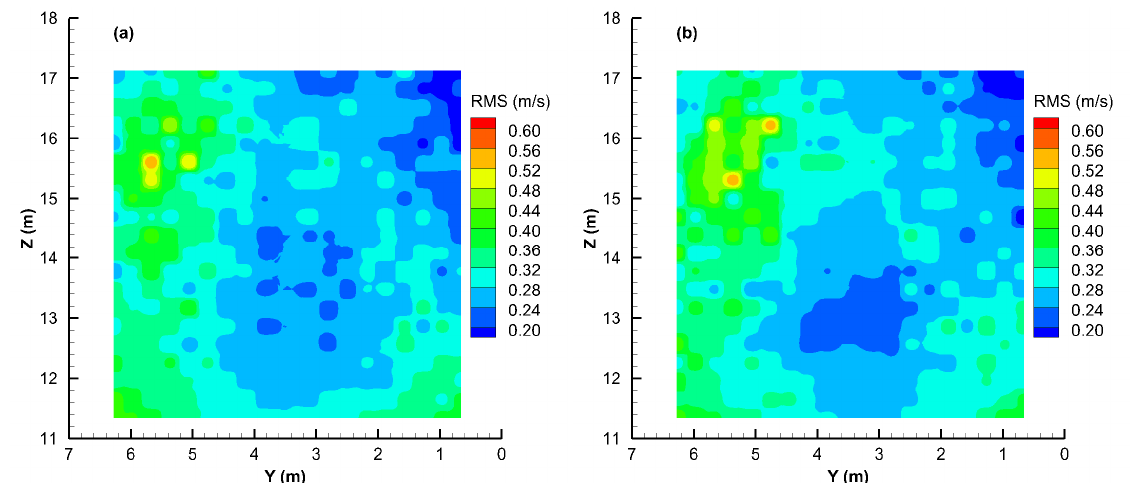
Figure 7. RMS velocity fluctuation contour at unit 14A, at a turbine unit discharge rate